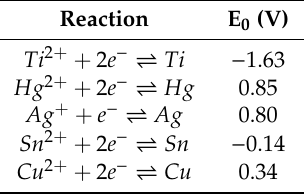
Table 1. Reduction potentials for Ti , mercury, silver, tin, and copper at 25 ◦ C [39].